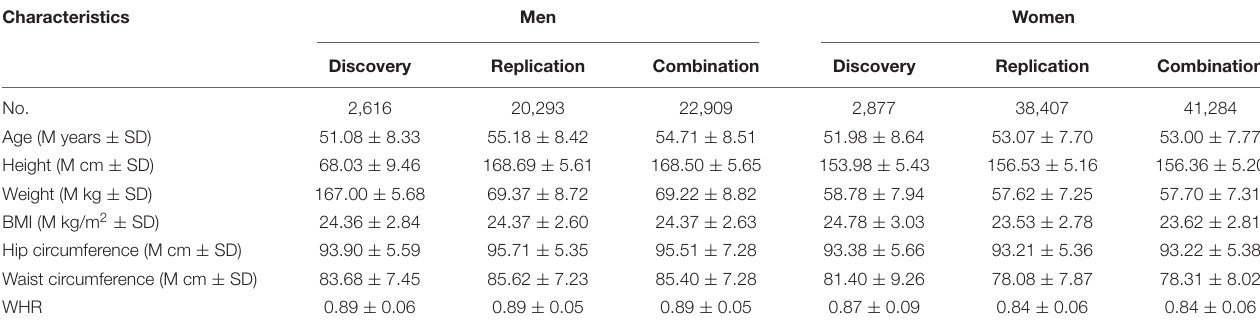
TABLE 1 | Characteristics of the study participants.